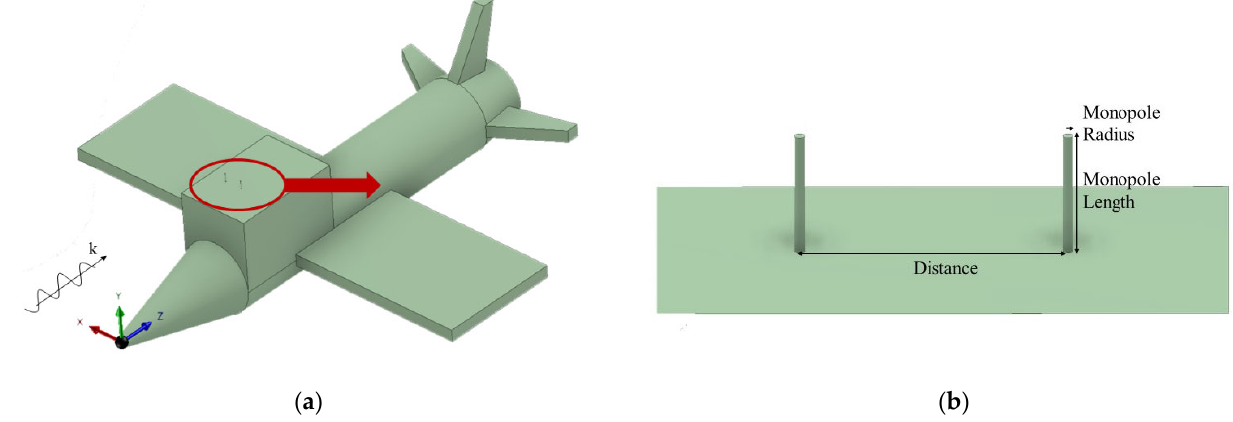
Figure 3. ( a ) 3D ‐ model of the aircraft model; ( b ) 3D ‐ model of the antenna system.